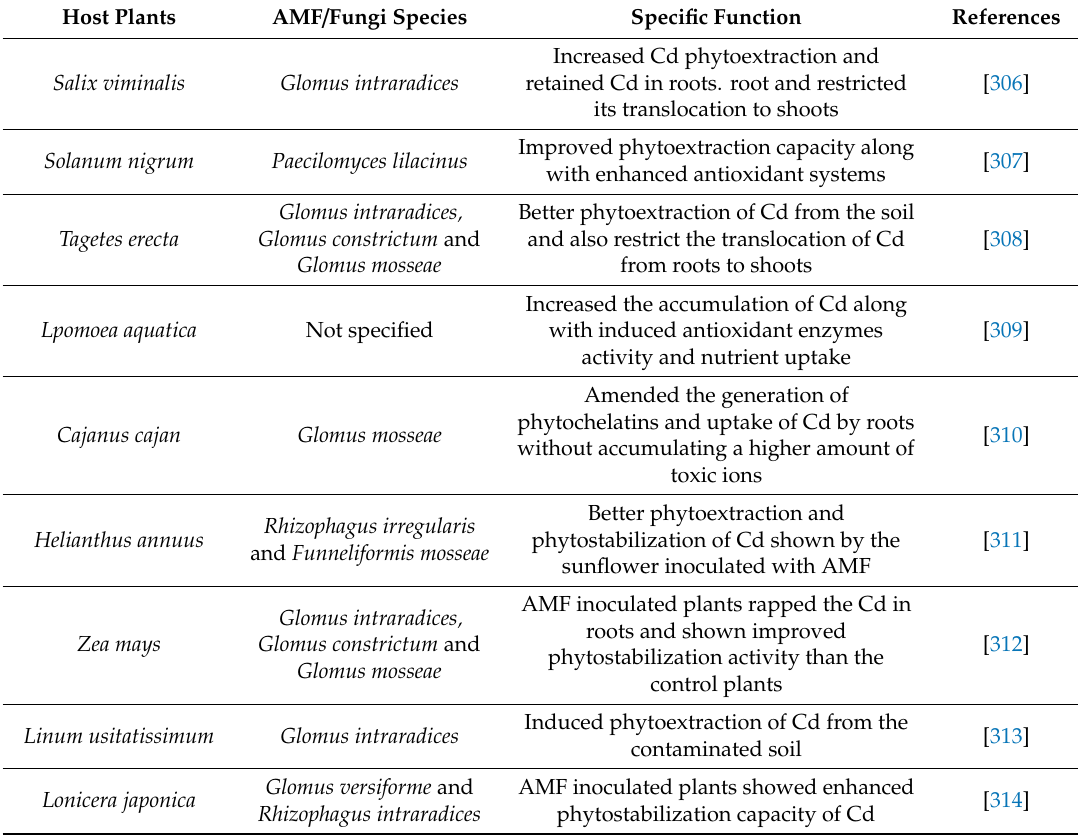
Table 8. Enlisted studies of arbuscular mycorrhizal fungi (AMF) / fungi and its role in Cd phytoremediation. Host Plants AMF / Fungi Species Specific